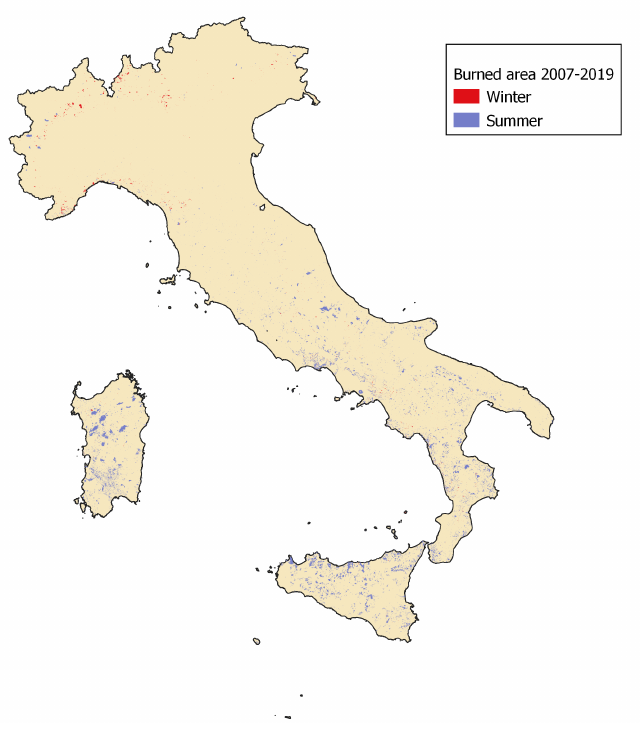
Figure 3. Spatial distribution of wildfire burned area in Italy for 2007 to